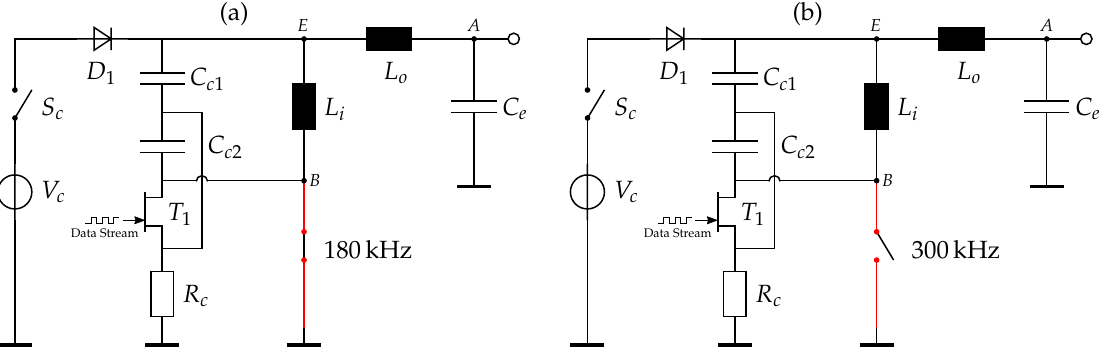
Figure 4. Interconnected oscillators—equivalent circuits for the filter at 180kHz ( a ) and 300kHz ( b ). In order to resonate at exactly 180 kHz, the interconnection between the tapped WPT LC circuit coil and the Colpitts oscillator capacitors ( C c 1 and C c 2 ) must be considered.